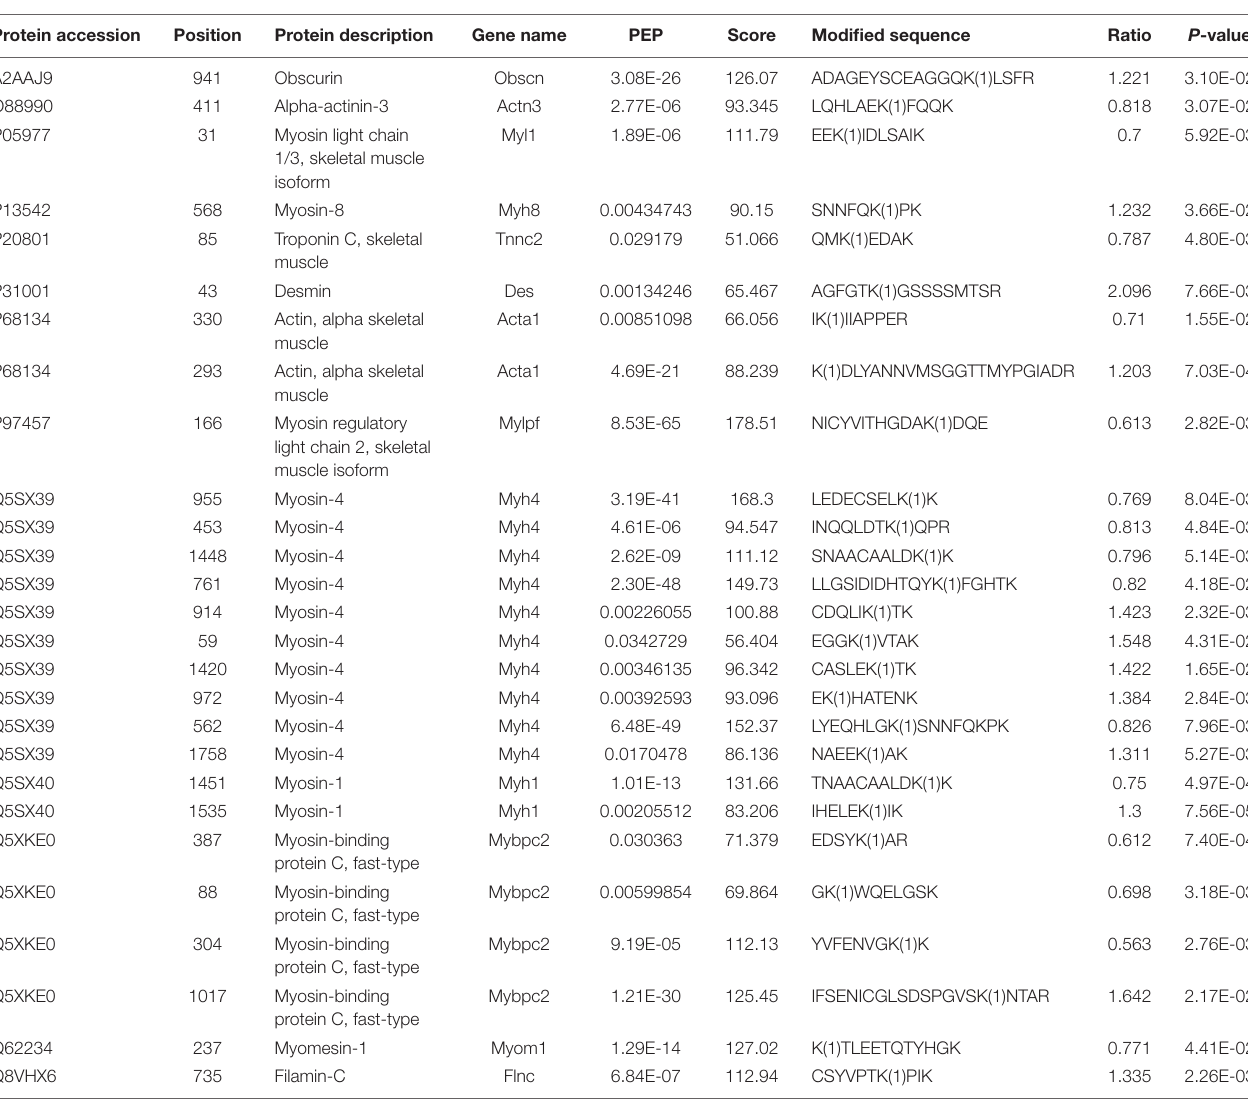
TABLE 2 | Alterations of lysine acetylation sites in proteins of muscle sarcomere during exercise. Protein accession Position Protein